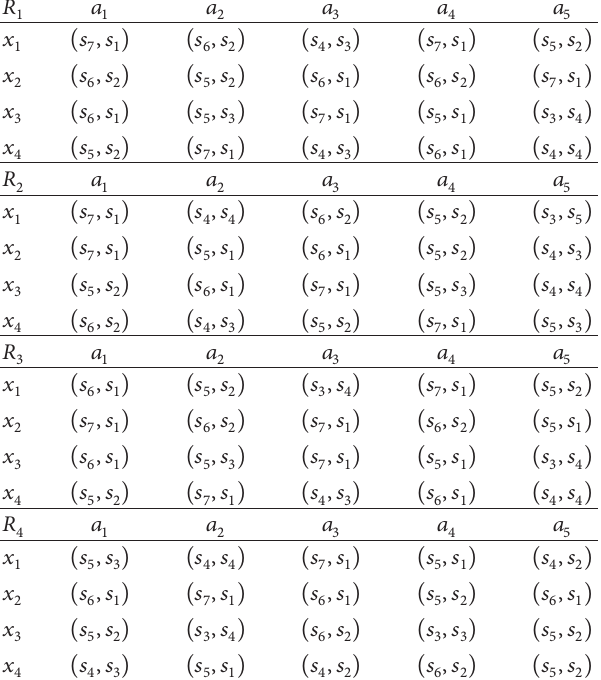
Table 4: Integrated decision matrix 𝑅 = (𝛾 𝑖𝑗 ) 𝑚×𝑛 .